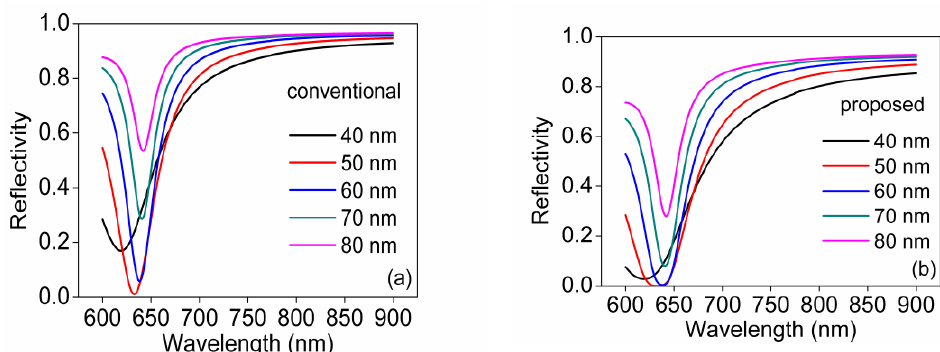
Figure 2. SPR spectrum for sample refractive index of 1.33, and Au film thickness of 40 nm, 50 nm, 60 nm, 70 nm and 80 nm. ( a ) The conventional sensor based on single BK7 prism; and ( b ) The proposed sensor based on bi-prism.